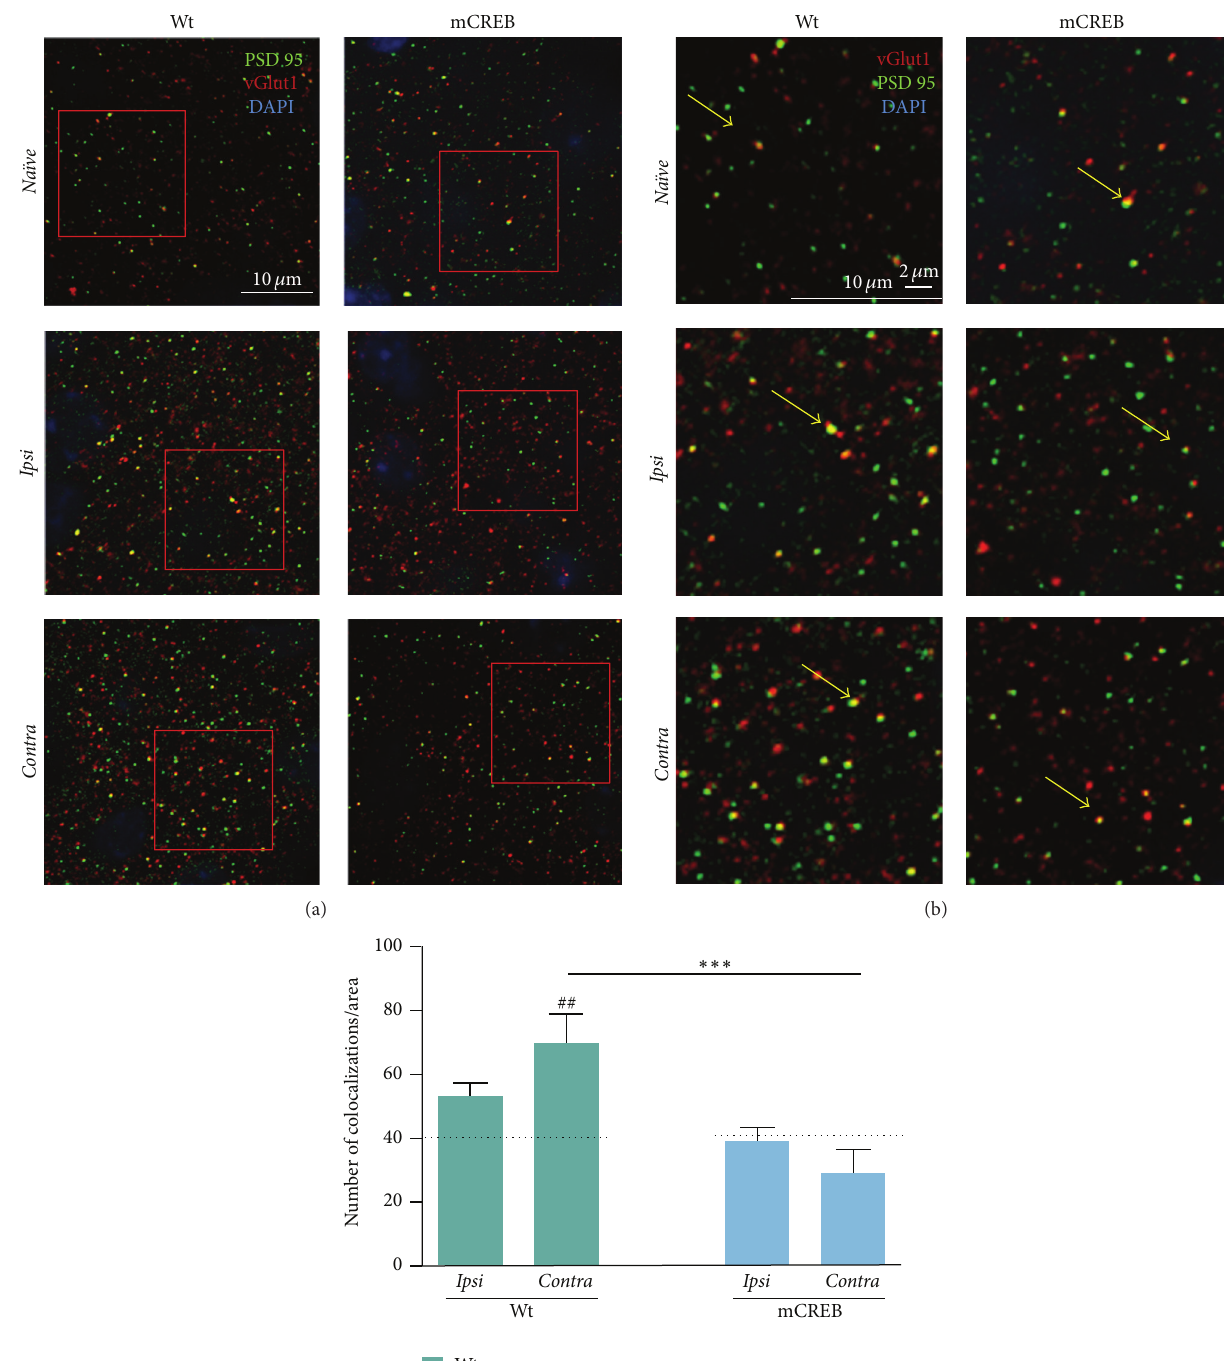
Figure 4: CREB function is necessary for whisker trimming-induced increase of synaptic contacts in Contra barrel cortex. (a) Representative images from wild type (WT) and mCREB mice in Na¨ıve and trimmed conditions ( Na¨ıve , Ipsi , and Contra , scale bar 10 𝜇 m). Sections were stained for the presynaptic marker vesicular glutamate transporter 1 (vGlut1) (Red), the postsynaptic marker PSD 95 (Green), and DAPI (blue). Red squares refer to areas magnified in (b). Colabelled puncta are shown in yellow; arrows mark examples of colaballed puncta (one example for each image). (c) Histogram showing the mean number of colocalizations of wild type (WT) and mCREB mice in trimmed condition. Dotted line indicates the average number of colocalizations in the relative Na¨ıve group. Colocalization was plotted as number of overlapping signals (mean ± s.e.m.) per 100 𝜇 m 2 . ## < 0.01 (difference from relative Na¨ıve ); ∗ ∗ ∗ < 0.001 (difference between genotypes). 𝑁 : 5 to 6 hemispheres for each